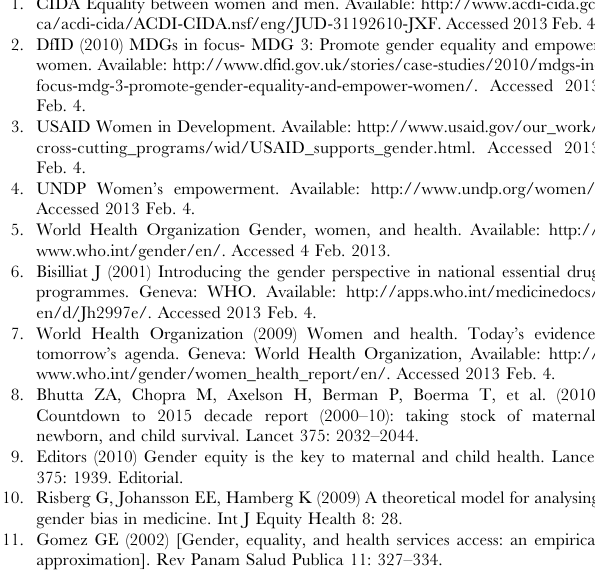
Table S1 Arthritis diagnosis and treatment. Table S2 Angina diagnosis and treatment. Table S3 Asthma diagnosis and treatment. Table S4 Depression diagnosis and treatment. Table S5 Schizophrenia diagnosis and treatment. Table S6 Diabetes diagnosis and treatment. Table S7 Need for and access to care among adults. Table S8 Need for and access to care among